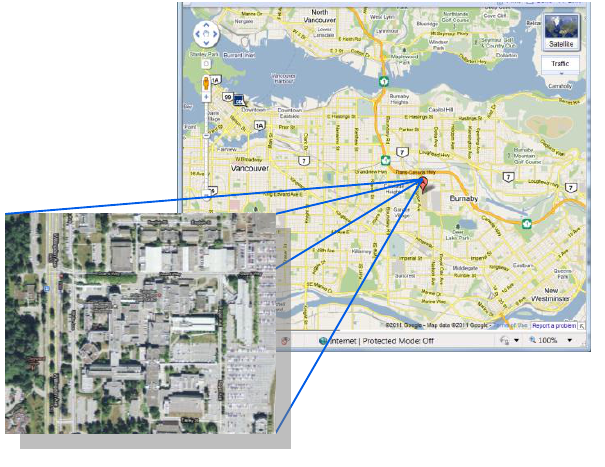
Figure 2: Study Area (British Colombia Institute of Technology,